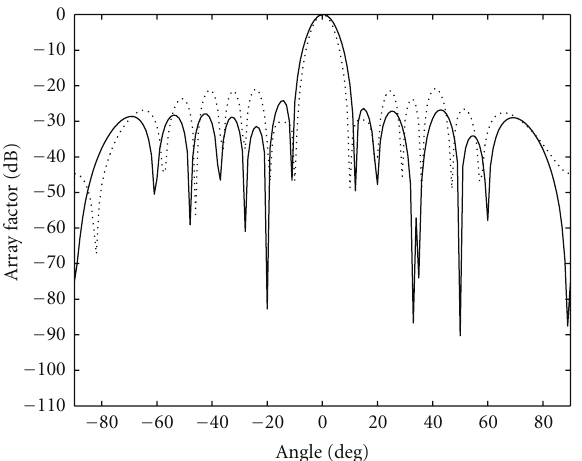
Figure 14: Radiation pattern for 2nd, 3rd, and 18th element failure with main beam at broadside and broad null at 30 ◦ . Dotted line curve shows the damaged array pattern and the solid line curve shows the corrected